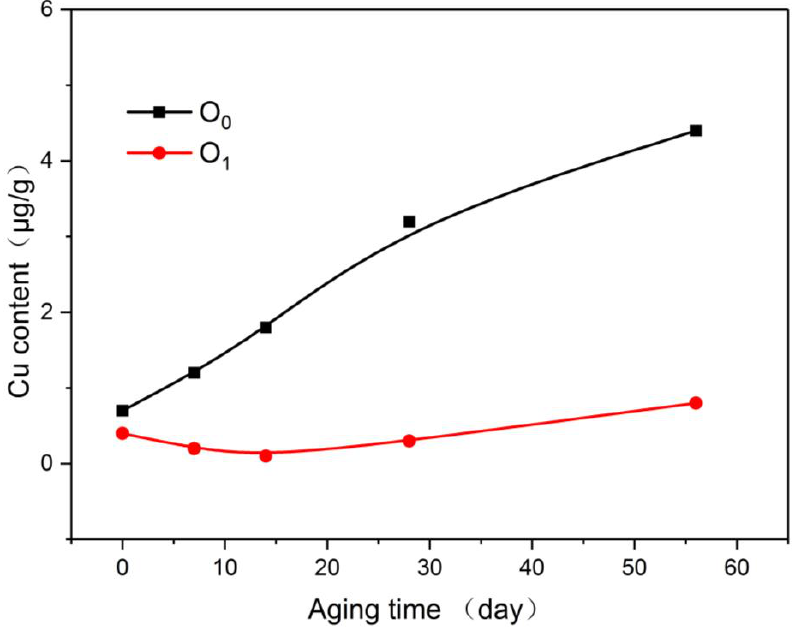
Figure 10. Variation of copper content in oil with aging process.